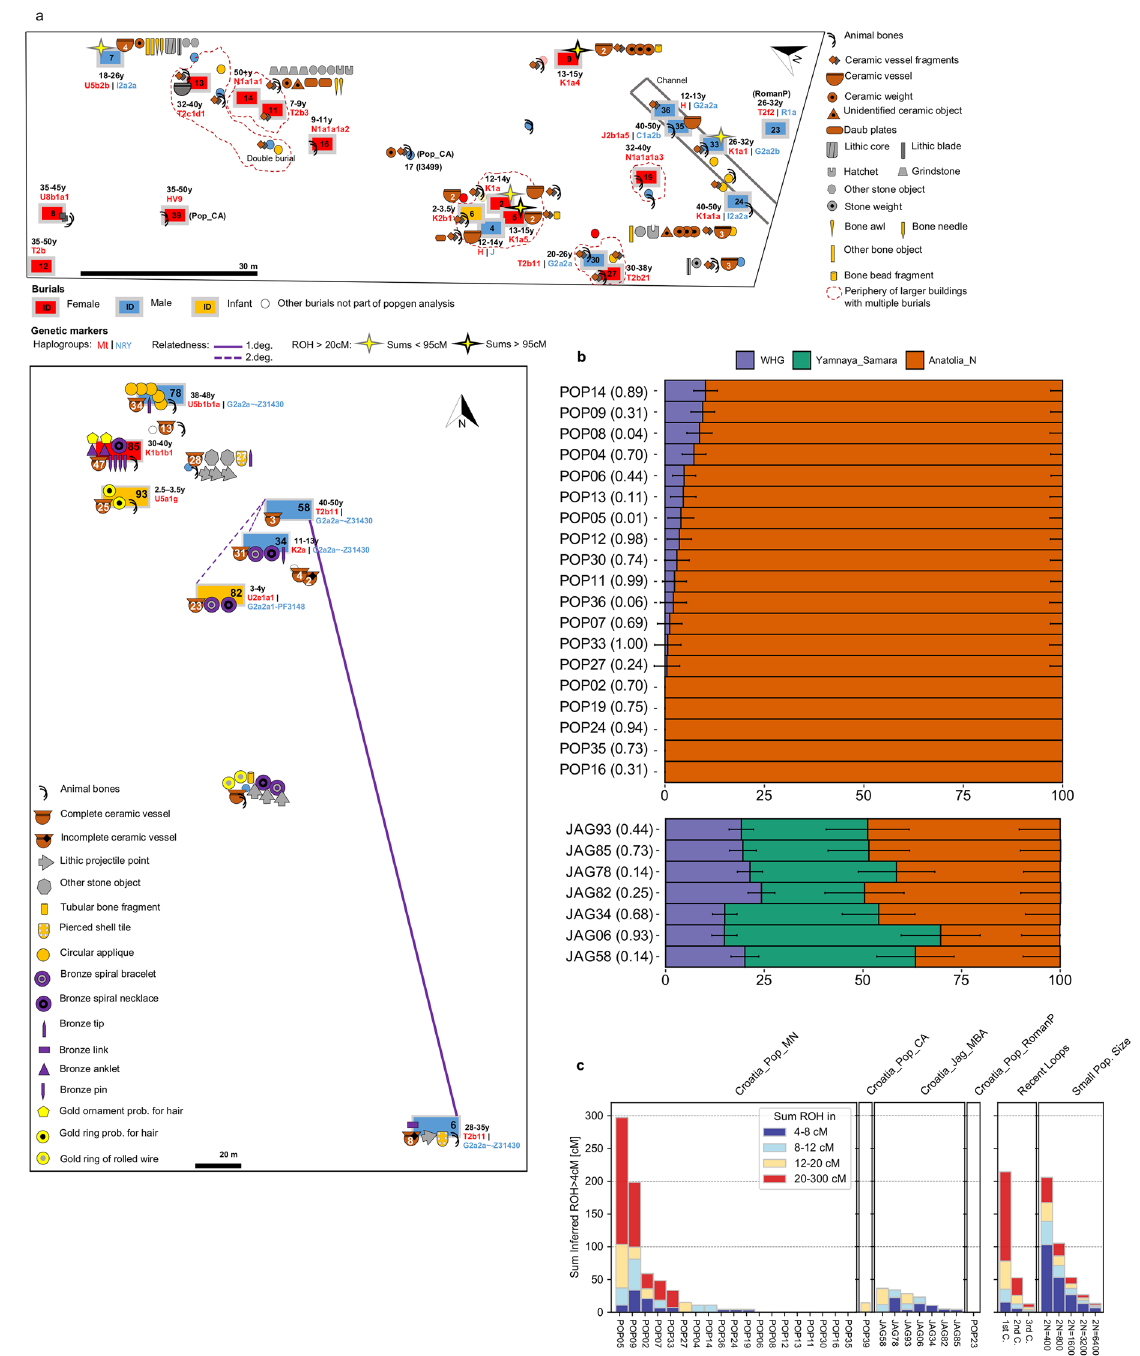
Figure 4. Burials and individual measures of genetic variation. ( a ) Plan of Popova zemlja (top) and Jagodnjak necropolis (bottom) showing inhumations, grave goods and demographic information. Burials with increased translucency indicate these were not sampled due to poor preservation or uncertain context. Burials without a fill colour indicate preservation was too poor for sex estimation. Number of grave good objects exceeding one are indicated. Estimated age at death is indicated as a range in years (y) for individuals included in population genetic analysis. Individuals with an estimated age at death of under 8 years are indicated as infants. ( b ) Stacked bar plots showing distal admixture models calculated with qpAdm for individuals from Croatia_Pop_MN (top) and Croatia_ Jag_MBA (bottom), with p-values stated in brackets. Nested two-way models between WHG and Anatolia_N are shown for Croatia_Pop_MN. Three-way admixture models between WHG, Anatolia_N and Yamnaya_Samara are shown for Jagodnjak. Standard error bars are shown as one standard error in each direction (Source data in Supplementary Table S4). Plot produced using R 3.5.2. 102 ( c ) Sums of inferred runs of homozygosity (ROH) greater than 4 cM calculated for each individual with hapROH (Source data in Supplementary Table S10). “Recent loops” and “Small Pop. Size”, generated by hapROH, show the expected distribution of ROH from simulated data for close parental relationships (C = cousin) and small effective population sizes respectively. Plot produced using R 3.5.2 102